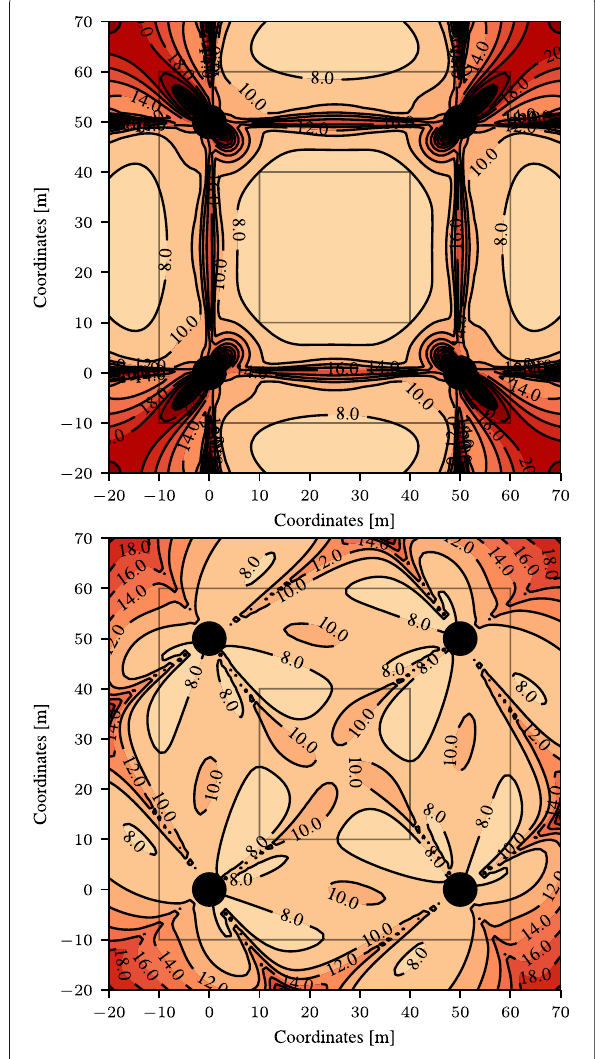
Fig. 4 CRLB for position estimation based on RSS-based DOA measurements depending on the node orientation. For both figures standard deviation is given in meters. a Position CRLB for a node orientation of 0° b Position CRLB for a node orientation of 35°